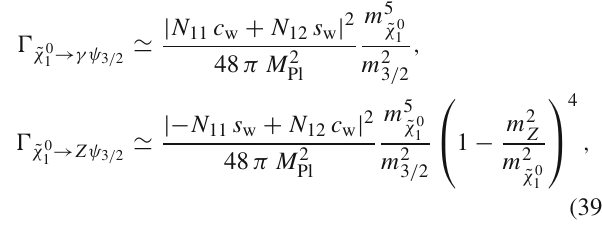
Table1 Theinputparameterswhicharefixedthroughoutournumerical analysis (interpreted as on-shell parameters if not specified otherwise). The gaugino mass parameters are denoted as M i with i = 1 , 2 , 3. The